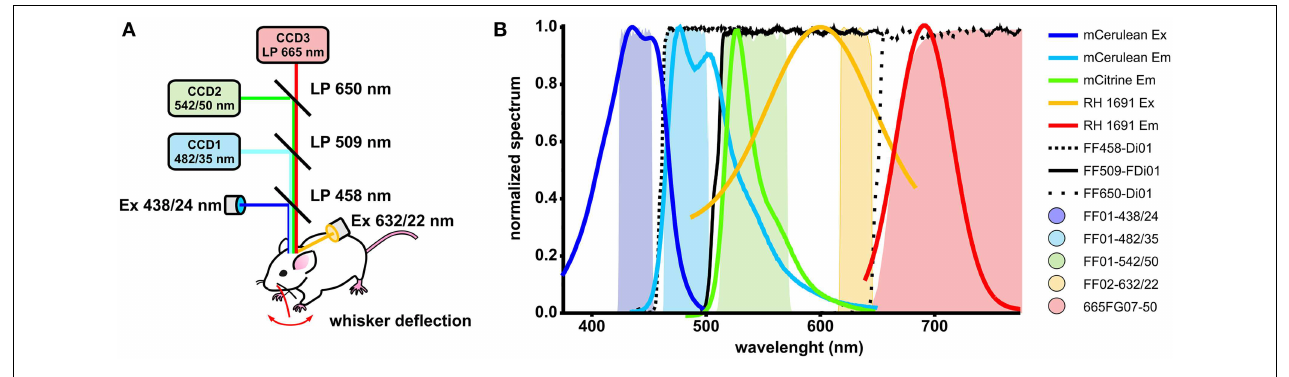
FIGURE 1 | In vivo optical voltage recording system, fluorophores spectra and filters and dichroic mirrors transmission spectra. (A) Schematic drawing of the optical system with three synchronized CCD cameras. Two excitation light sources are used: blue light to excite VSFP2.3